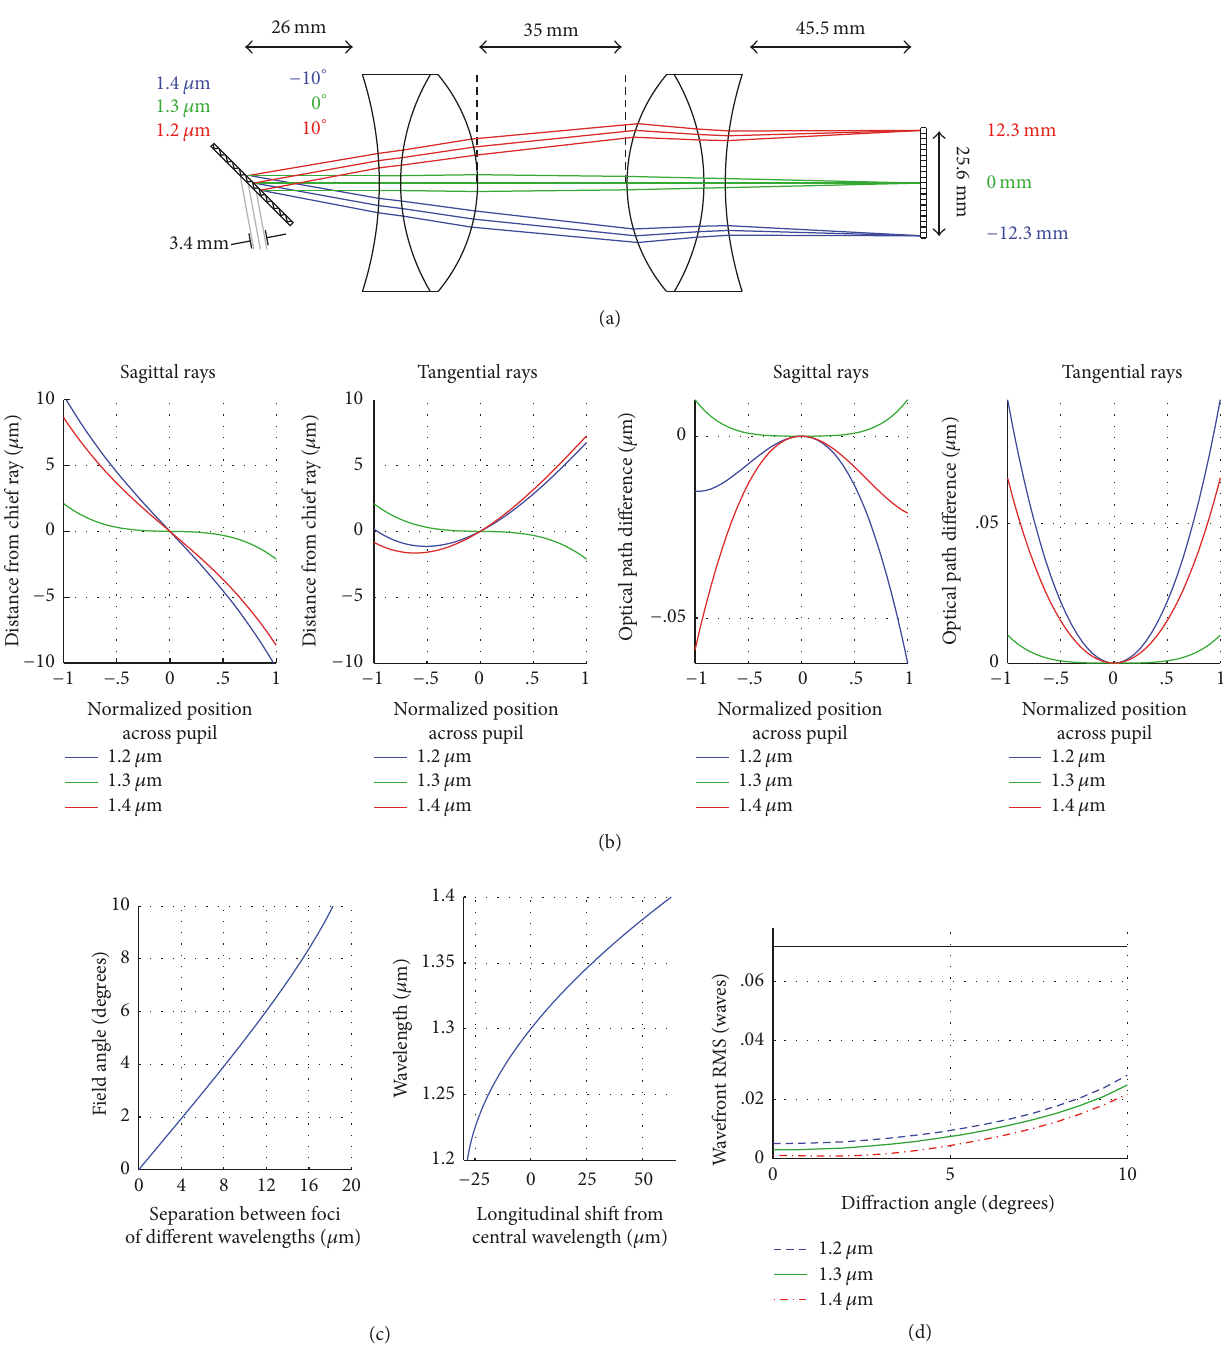
Figure 3: A schematic of the spectrometer. The grating diffracts the broadband collimated beam. The lens system acts as a scan lens and focuses the diffracted light beams on the focal plane array of a line scan camera. The focal length of the lens mechanism is designed such that the desired spectrum (1200nm to 1400 nm) is covering the extent of the detector array. Optical aberrations in this scan lens system are minimized to reduce the sensitivity roll-off of the OCT